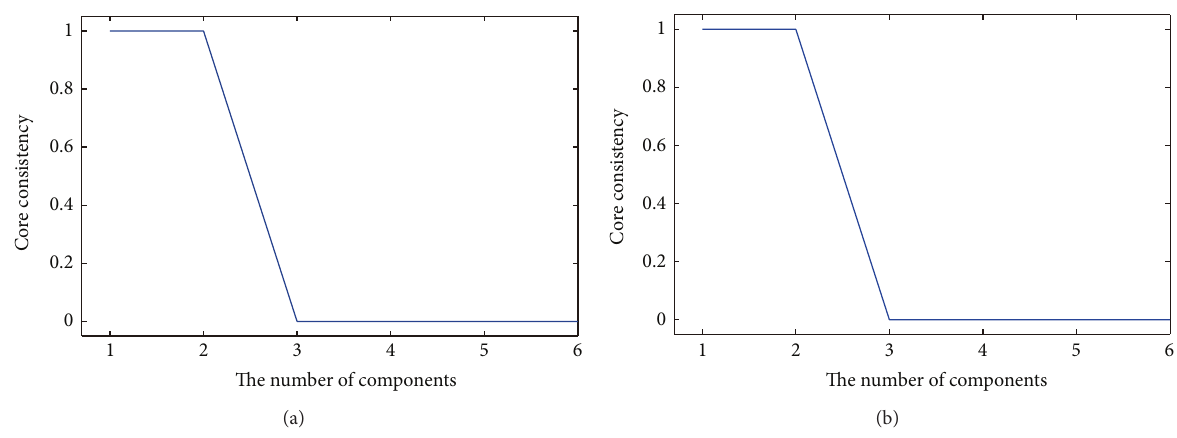
Figure 3: The core consistency value about valsartan (a) and amlodipine besylate (b) in human plasma.